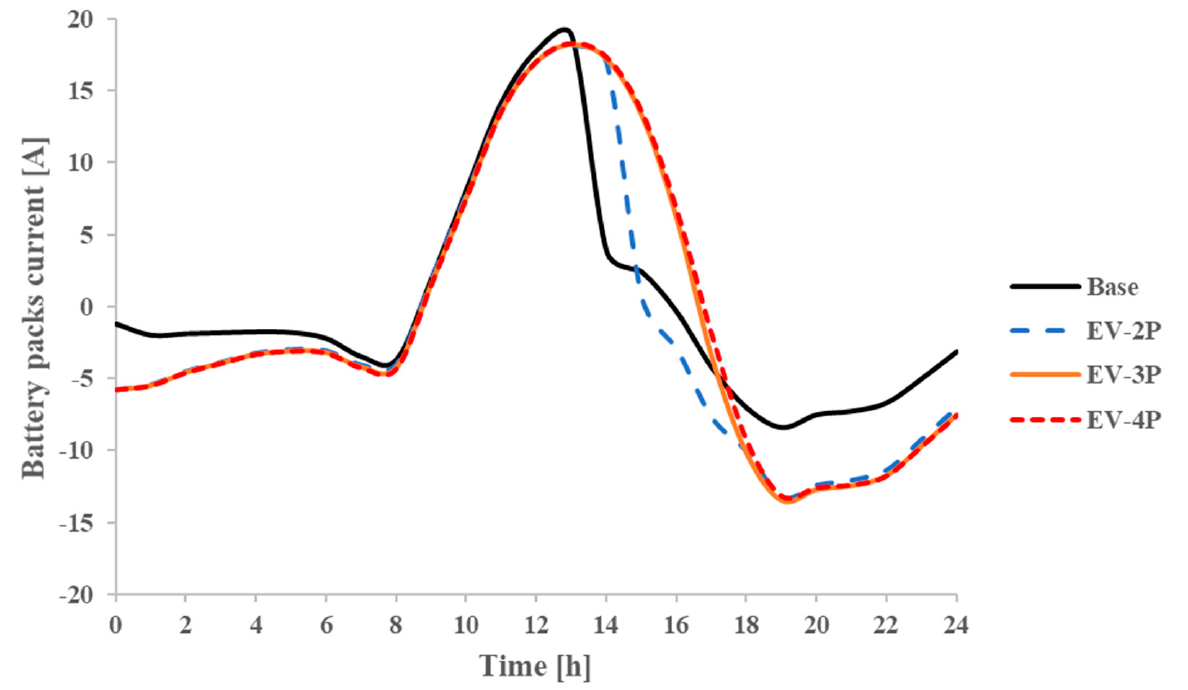
Figure 12. Second life battery current for different scenarios during the day.